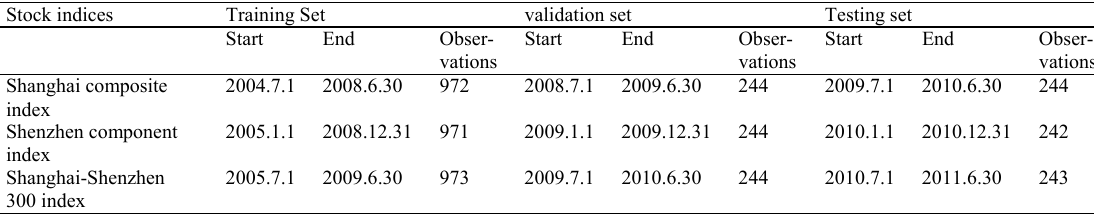
Table 1. Time series: training set, validation set and testing